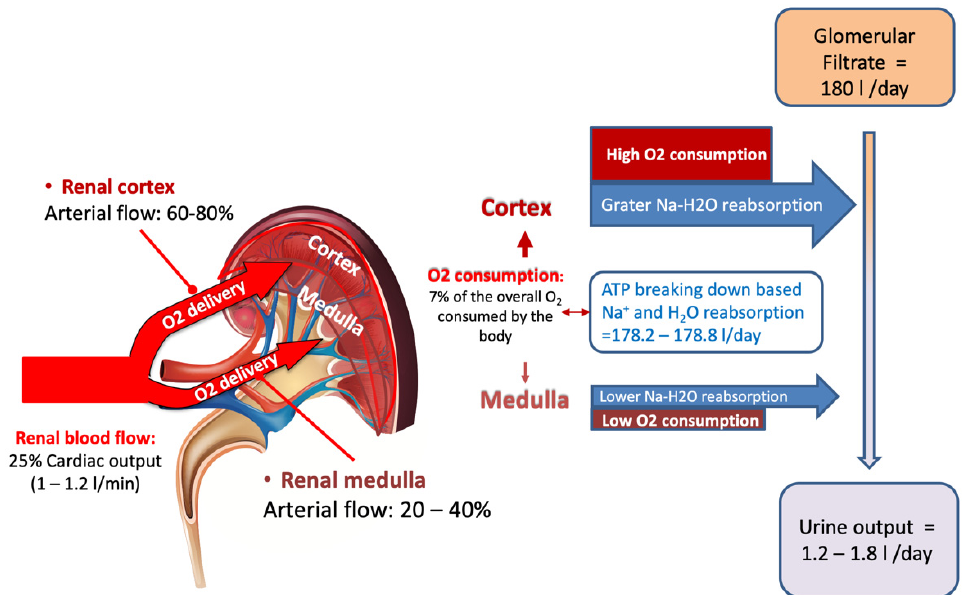
Figure 1. Despite renal mass accounts only for 0.5% of total body mass, 25% of cardiac output is delivered to the kidney, which consumes the 7% of the whole body oxygen consumption. Renal oxygen consumption is mostly connected to the selective reabsorption of glomerular filtrate that corresponds to approximately to 180 L/day, while daily urine output is restricted to 1.2–1.8 L/day. The largest reabsorption work takes place in the proximal segment of glomerular tubule in the cortex area, where arterial blood flow provides the highest oxygen delivery to supply energy for urine concentration and selective solutes excretion (see text for details).